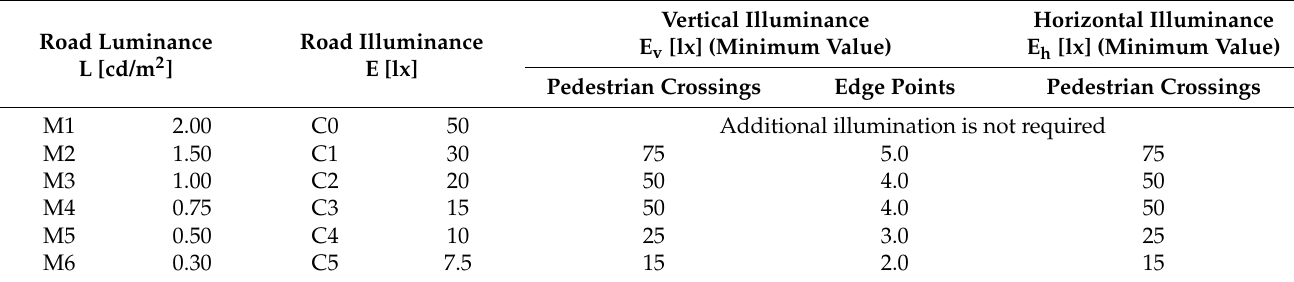
Table 2. Recommended lighting parameters at zebra crossings